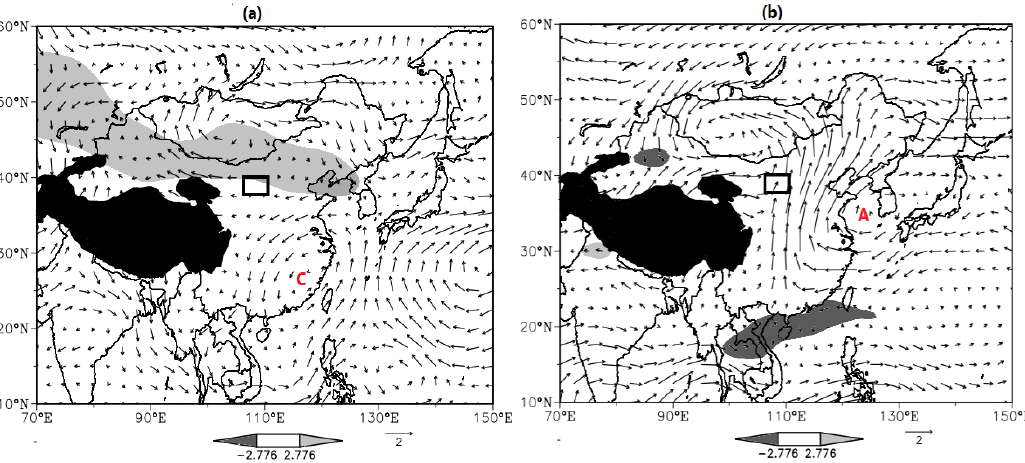
Figure 7. 850 hPa anomalous wind field (Unit: m·s −1 ) in the summer of typical drought years ( a ) and flood years ( b ). The gray shaded areas indicate the area passing the 0.05 significance test. The heavy shaded area denotes the Qinghai-Tibet Plateau.